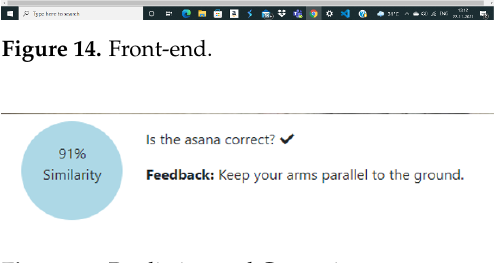
Figure 15. Prediction and